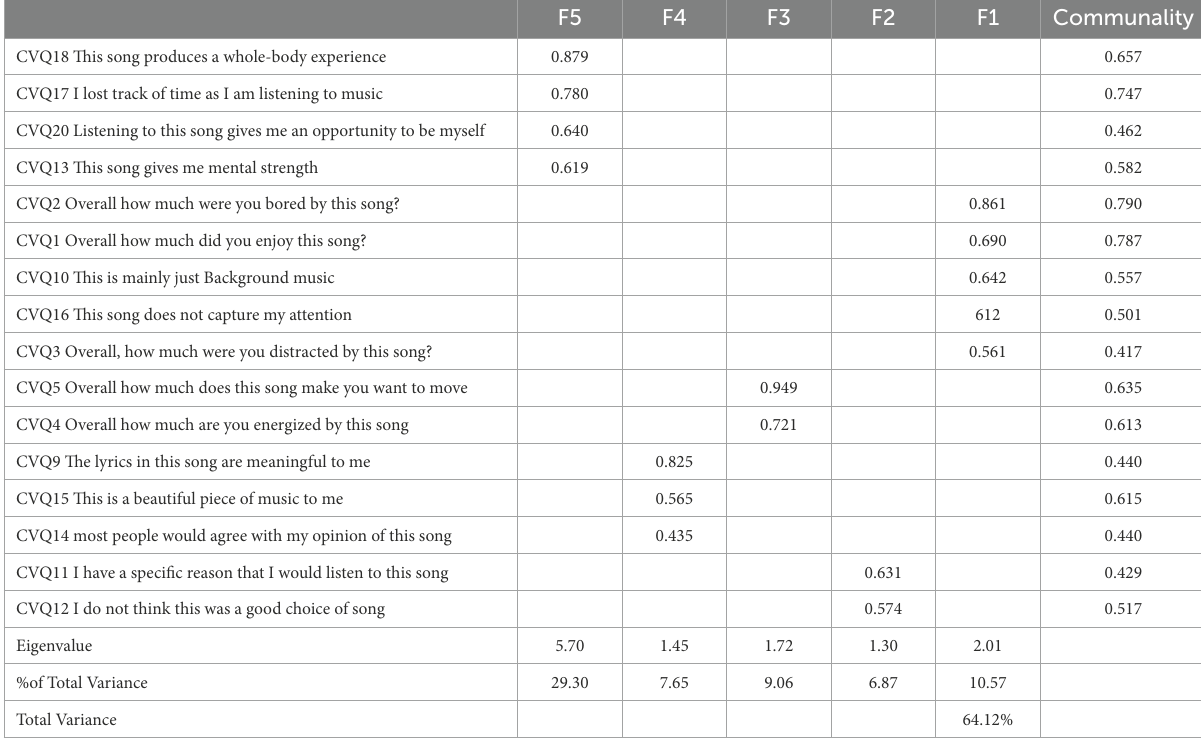
TABLE 3 Factor analysis table for cognitive vitality